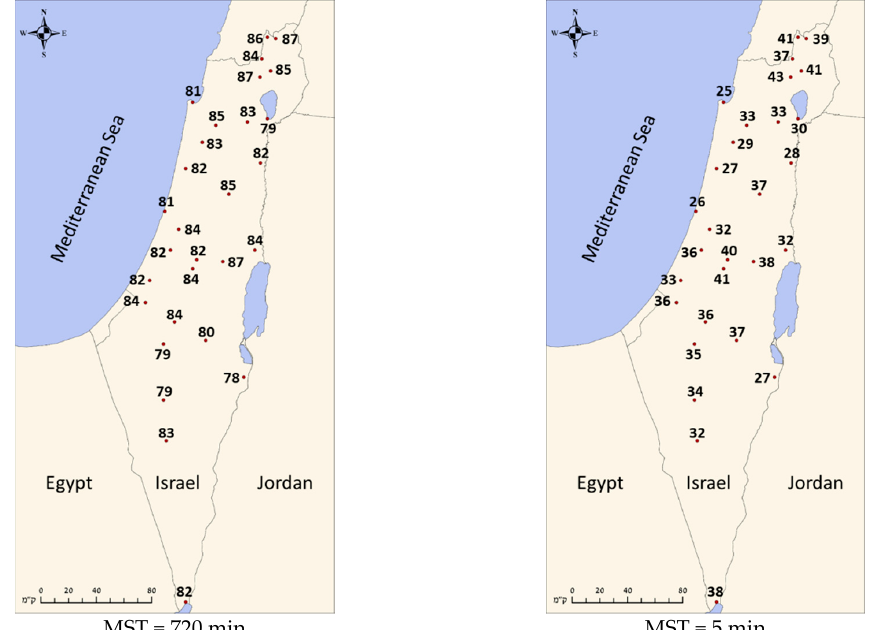
Figure 8. Percentage of Wet Time Duration (WTD) from Rain Spell Duration (RSD) for two selected Minimum Separation Time (MST).